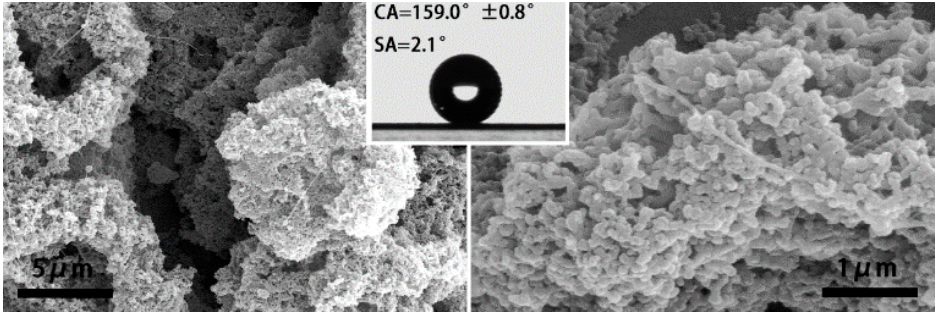
Figure 6. SEM image of the membrane fabricated under the condition of best parameter combination in all experiments.